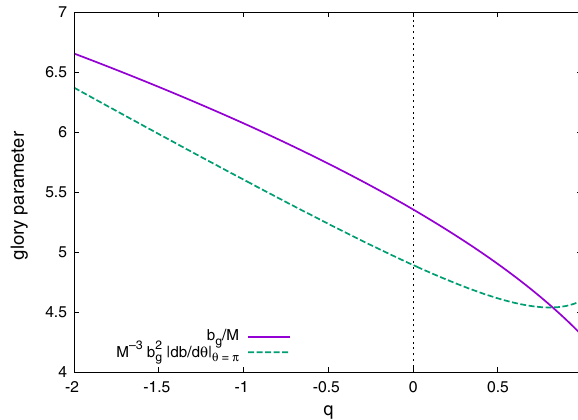
Fig. 2 The classical parameters which govern the glory ring widths and intensities as functions of